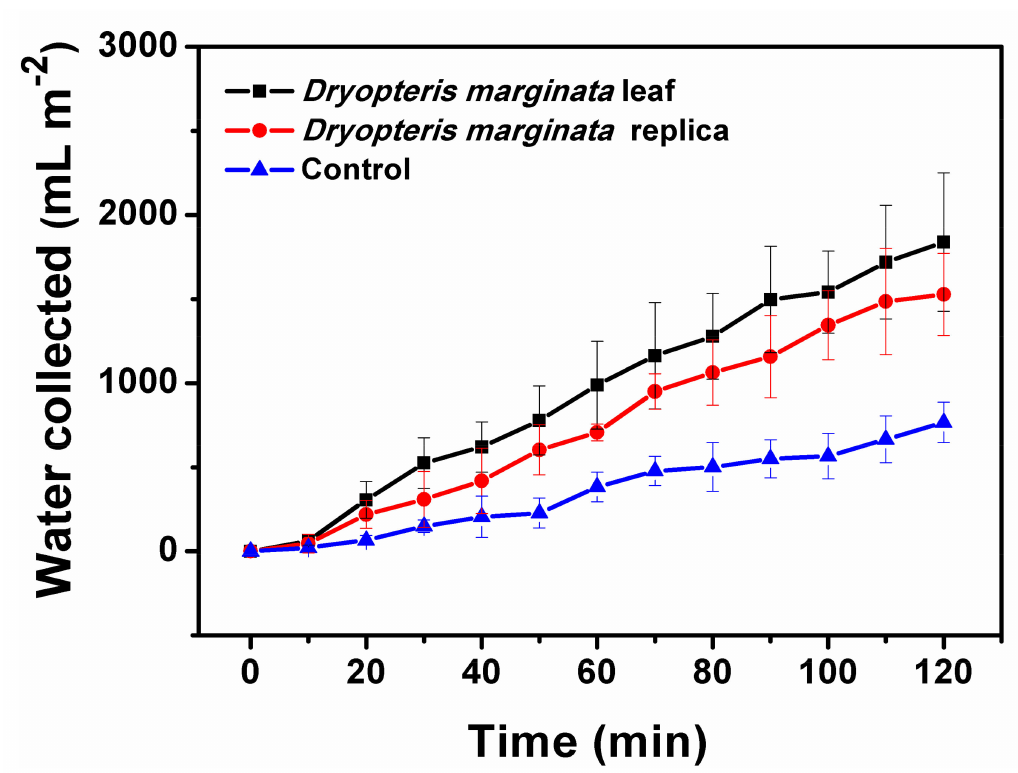
Figure 8. Water collection dynamics of the different substrates. Amount of water collected by surfaces exposed to fog flow at intervals from 0 to 120 min with 10 min increments, shown as the mean ± standard